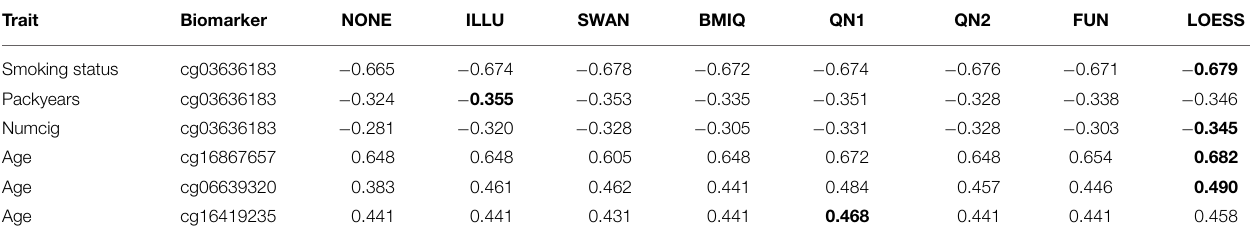
TABLE 1 | Results of the third